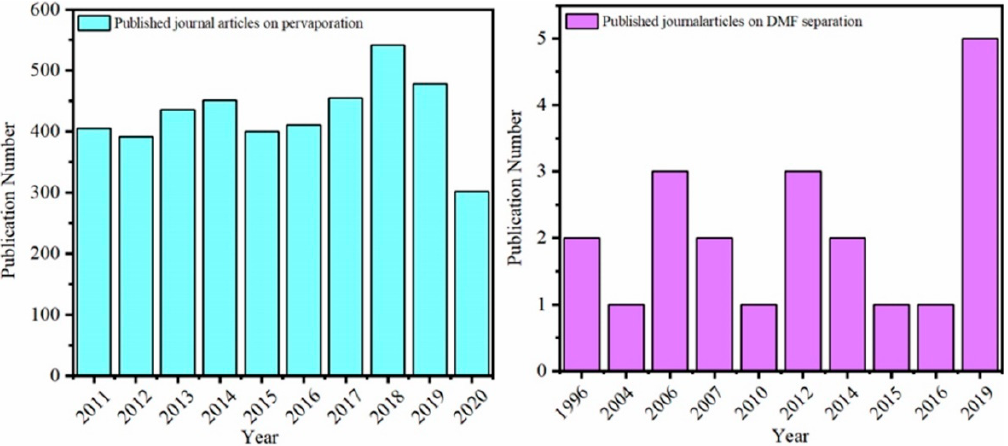
Figure 4. Recent published journal articles on pervaporation and DMF separation. Data were obtained from the Web of Science.